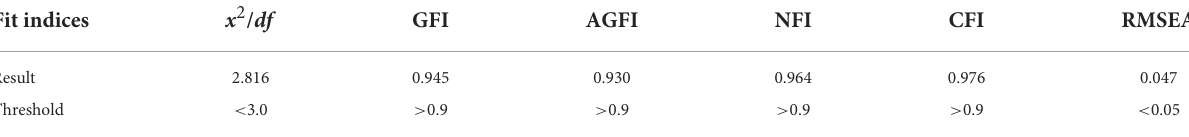
TABLE 1 Results of CFA.